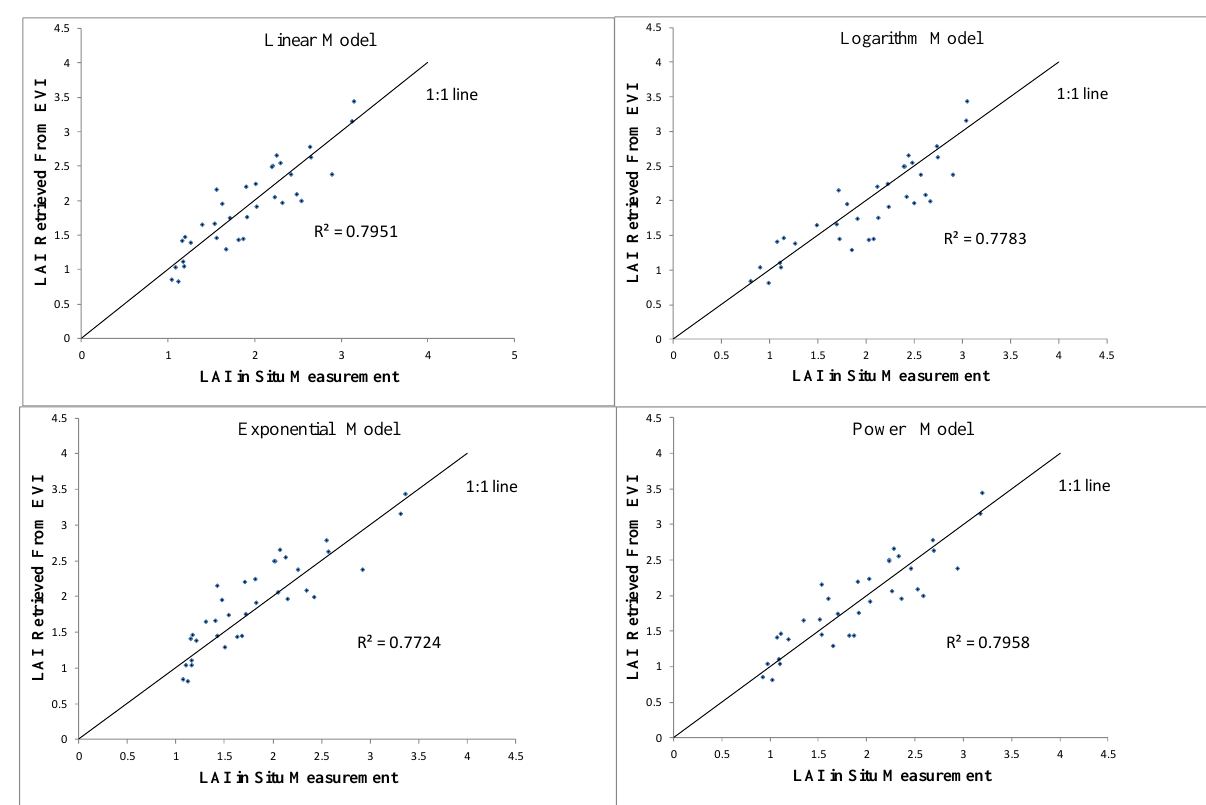
Figure 5. The estimation model of LAI on EVI .